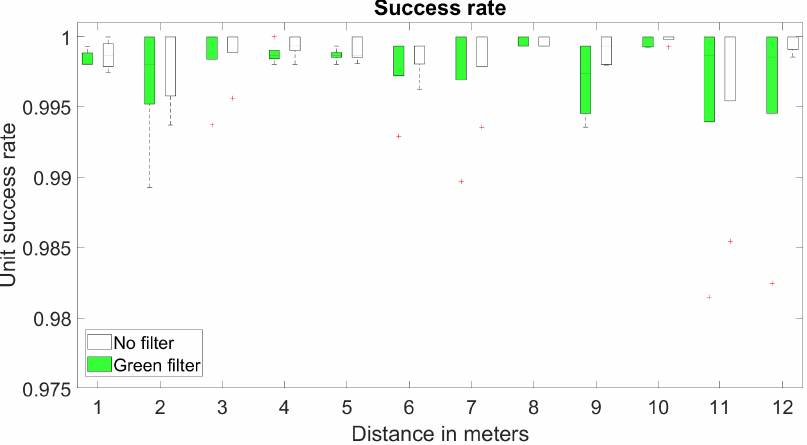
Figure 14. Box plot of success rate as unit